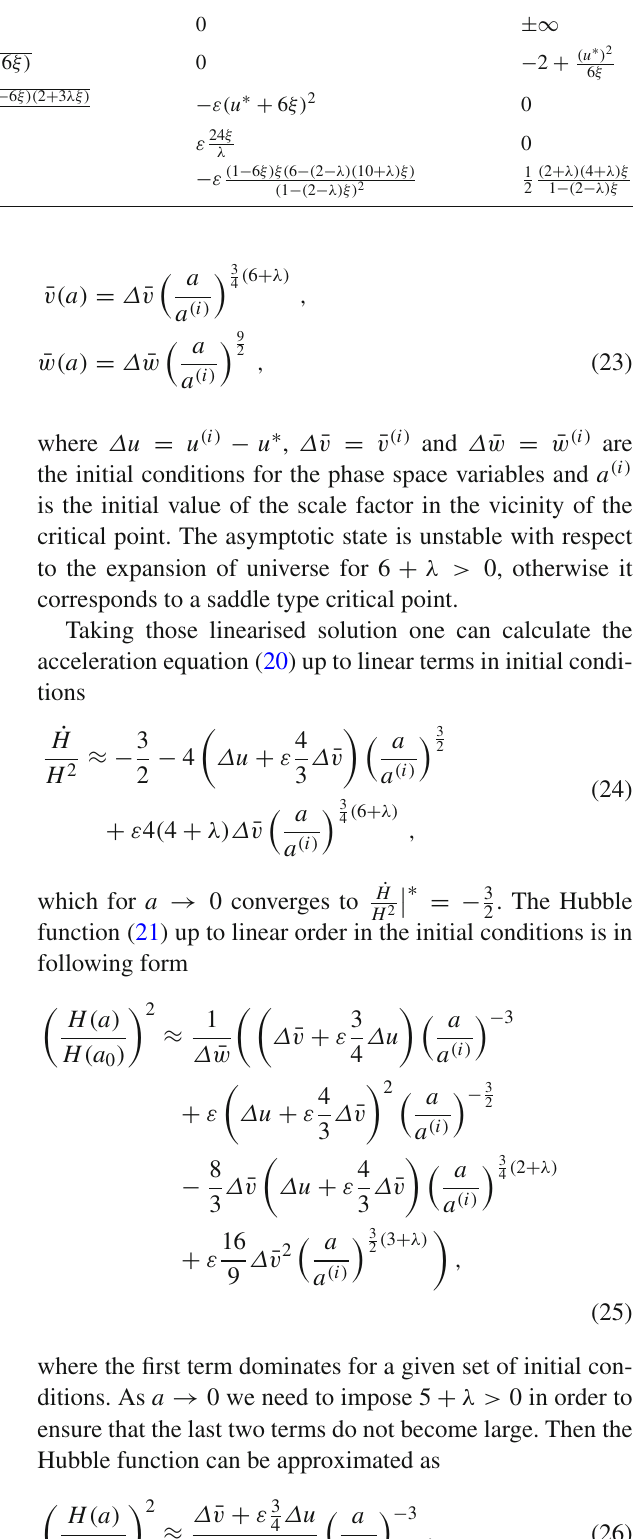
Table 1 The critical points of the decoupled two dimensional part of the system (18) and corresponding values of the acceleration equation